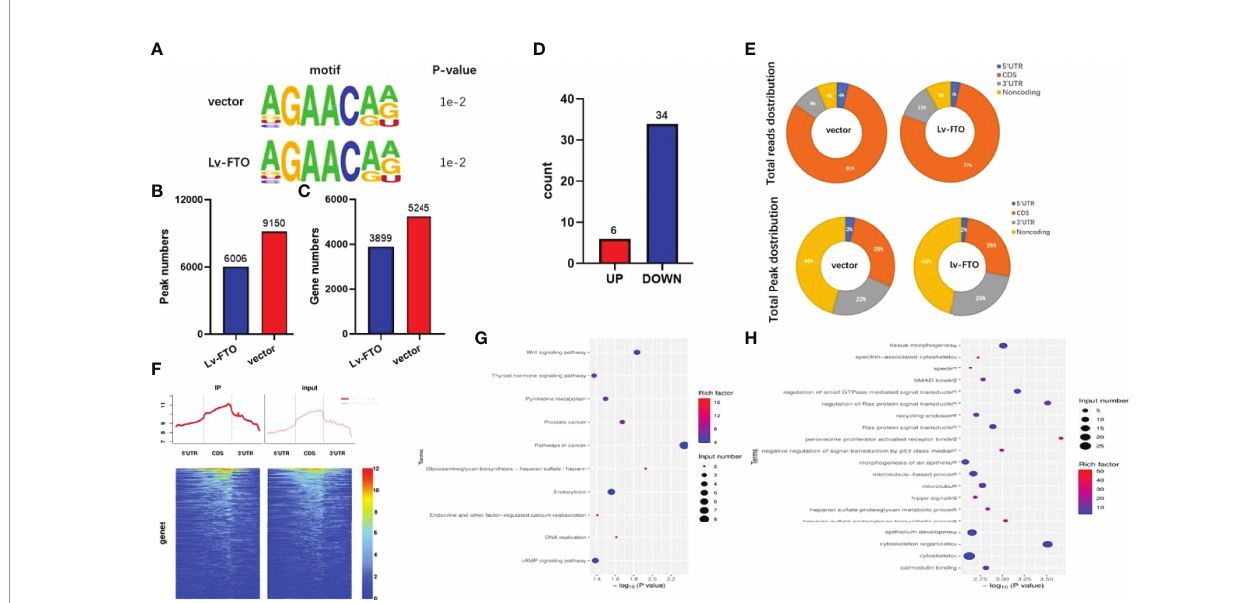
FIGURE 4 | FTO effects on the transcription pro fi le of papillary thyroid carcinoma (PTC) cells by meRIP-Seq. (A) The motif analysis performed using the HOMER program showed that “ GAACA ” is the m6A consensus motif of TPC-1-vector and TPC-1-Lv-FTO cells. (B, C) m6A-seq measures the number of m6A peaks and genes in TPC-1 cells. (D, E) Graphs of m6A peaks and reads distribution illustrating the proportion of common m6A peaks in the indicated regions in TPC-1 cells. (F) Distribution map (and heat map) of reads in the peak gene functional area. (G) Compared to PTC-1-vector cells, Kyoto Encyclopedia of Genes and Genomes analysis of m6A methylation downregulated genes in the m6A sequencing of PTC-1-Lv-FTO cells. (H) Compared to PTC-1-vector cells, gene ontology analysis of m6A methylation downregulated genes in the m6A sequencing of PTC-1-Lv-FTO